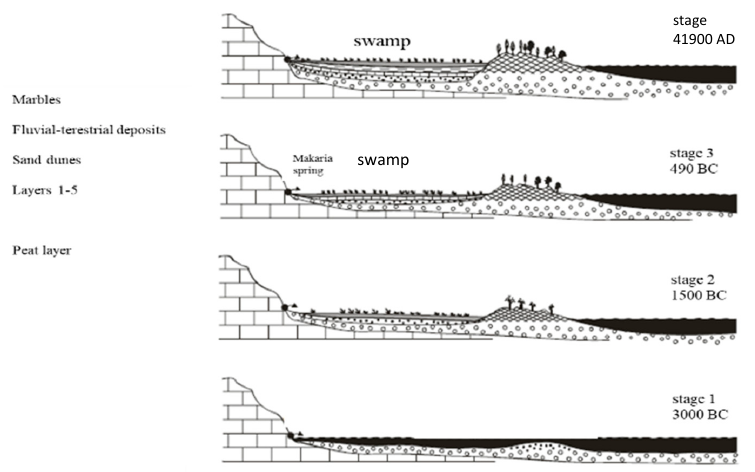
Figure 3. Sketch showing the Holocene evolution of the Schinias pinewood and marsh. The transverse cut corresponds to the straight red line in the previous panel. Four stages span the time from prehistory (stage 1) to the present (stage 4).